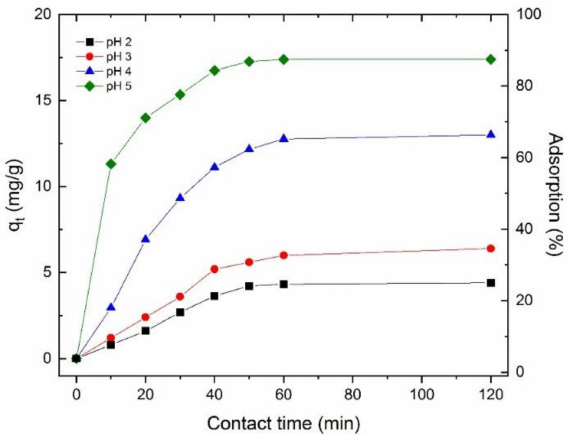
Figure 6. Influence of the solution pH on the terbium adsorption. Feed phase: 0.005 g/L Tb. Adsorbent dosage: 0.25 g/L. Temperature: 25 ◦